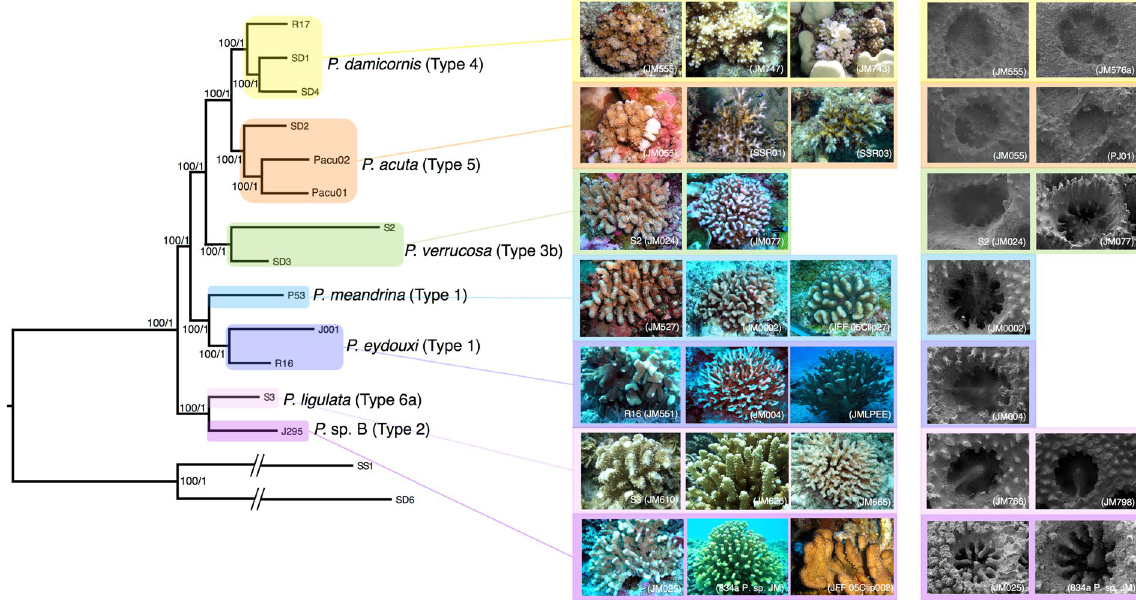
Figure 1. Maximum likelihood and Bayesian (ML/B) phylogenetic analysis of holobiont ezRAD data for 13 Pocillopora taxa where yellow: Pocillopora damicornis ; orange: P. acuta ; green: P. verrucosa ; light blue: P. meandrina ; dark blue: P. eydouxi ; light purple: P. ligulata ; dark purple: P . sp. B. and two outgroups, Stylophora pistillata (SD6), Seriatopora hystrix (SS1). Colony images provided by J. Maragos (JM), S. Schmidt-Roach (SSR), J-F. Flot (JFF). All SEM images were provided by Z.